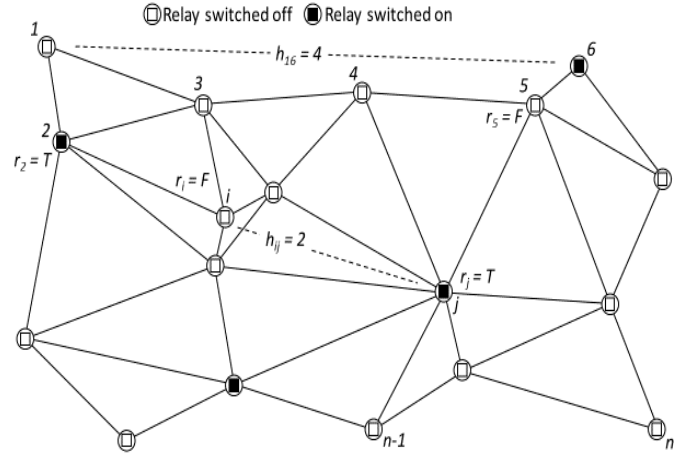
Figure 1. A flexible optical network (FON) with OEOs (relays) at all locations.